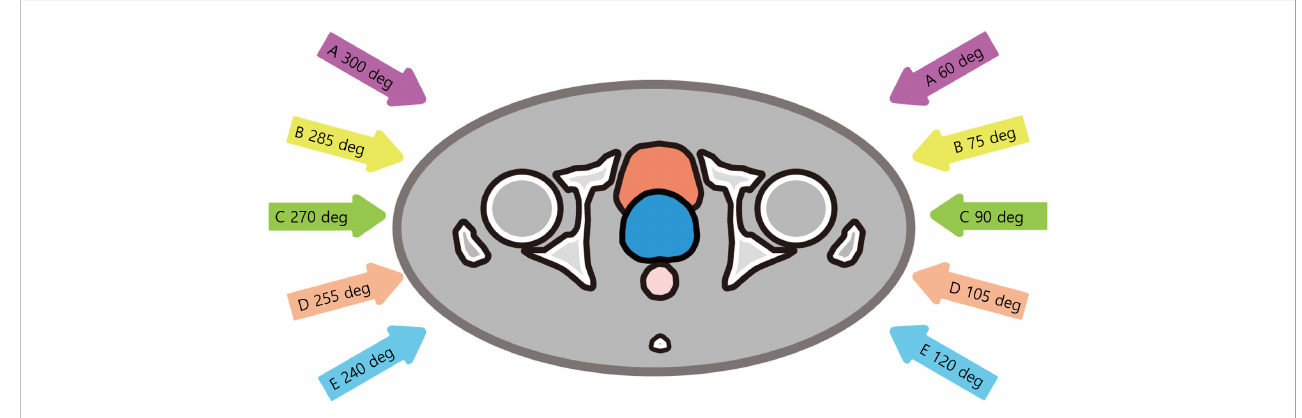
FIGURE 1 Beam angle con fi gurations in this